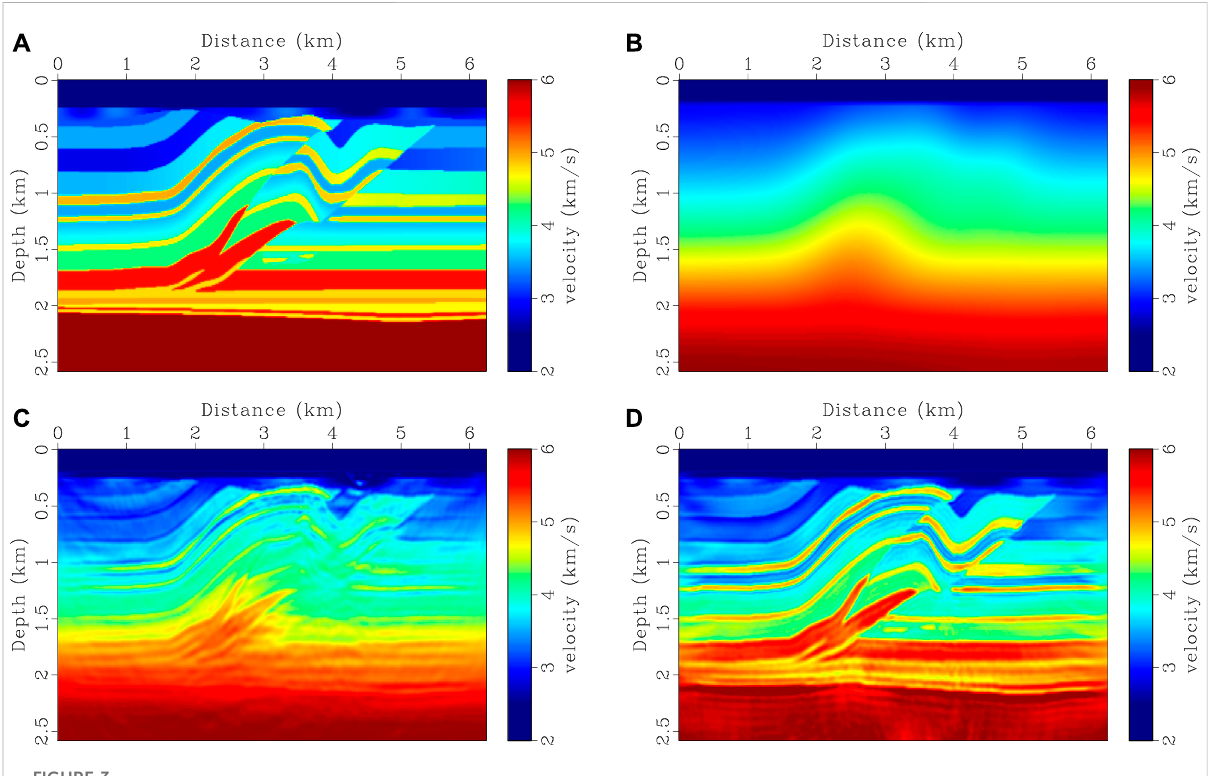
FIGURE 3 FWI experiments for SEG/EAGE overthrust model. (A) True velocity model, (B) initial velocity model, (C) recovered velocity model using CSV- basedFWI,and (D) recovered velocitymodelusing HG-based FWI. 40iterations areperformedin (C,D) .The lowest effective frequencyused in (C,D) is 5